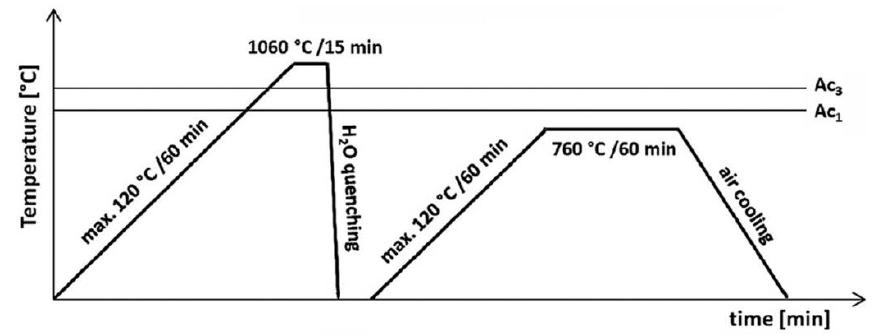
Figure 1. Scheme of unconventional “quenching-and-tempering” post-welding heat treatment (QT PWHT).